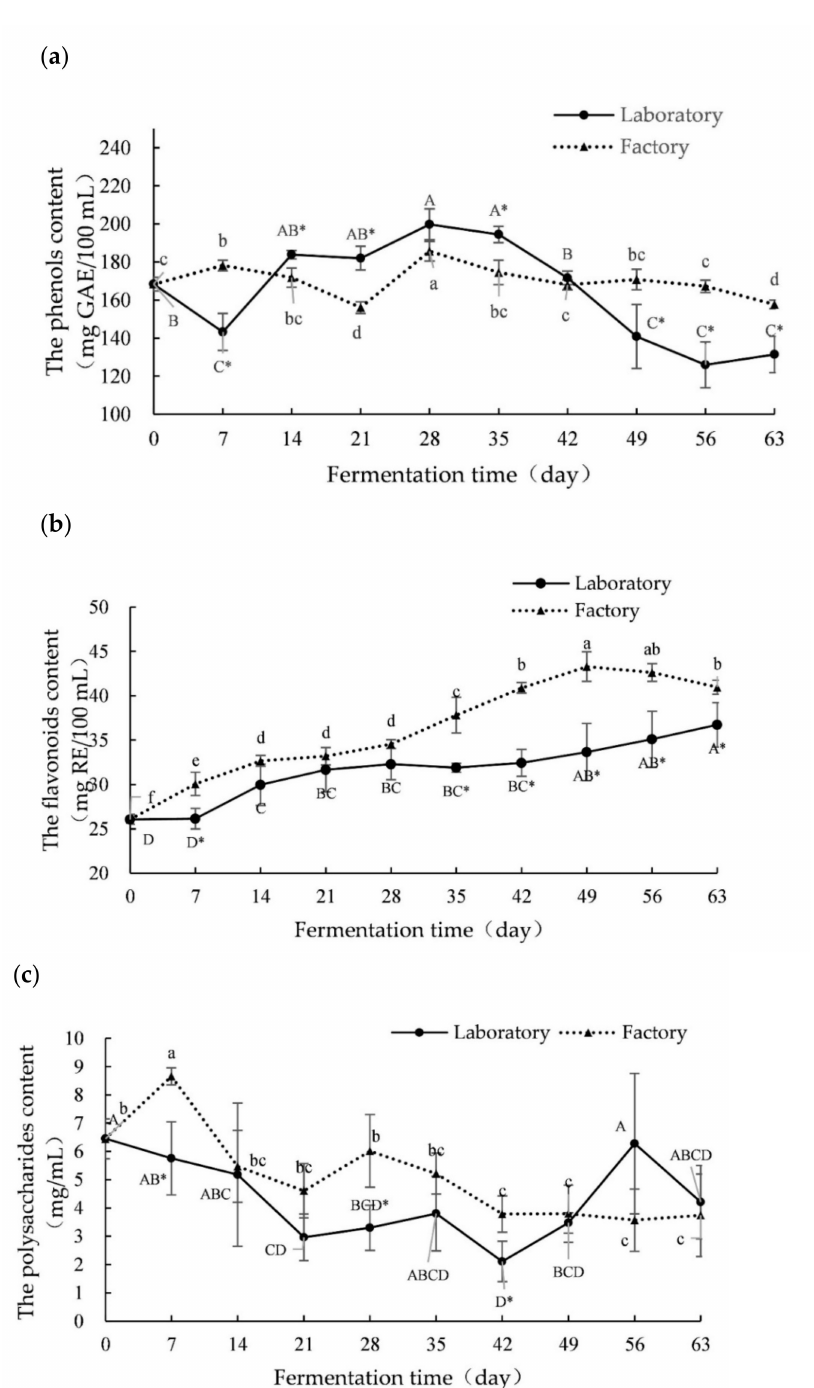
Figure 1. Changes in the total phenols ( a ), flavonoids ( b ) and polysaccharides ( c ) content during laboratory- and factory-scale fermentation. Different letters in the same line represent significant differences at p < 0.05. * represents a significant difference between the laboratory and the factory at the same fermentation time point ( p <